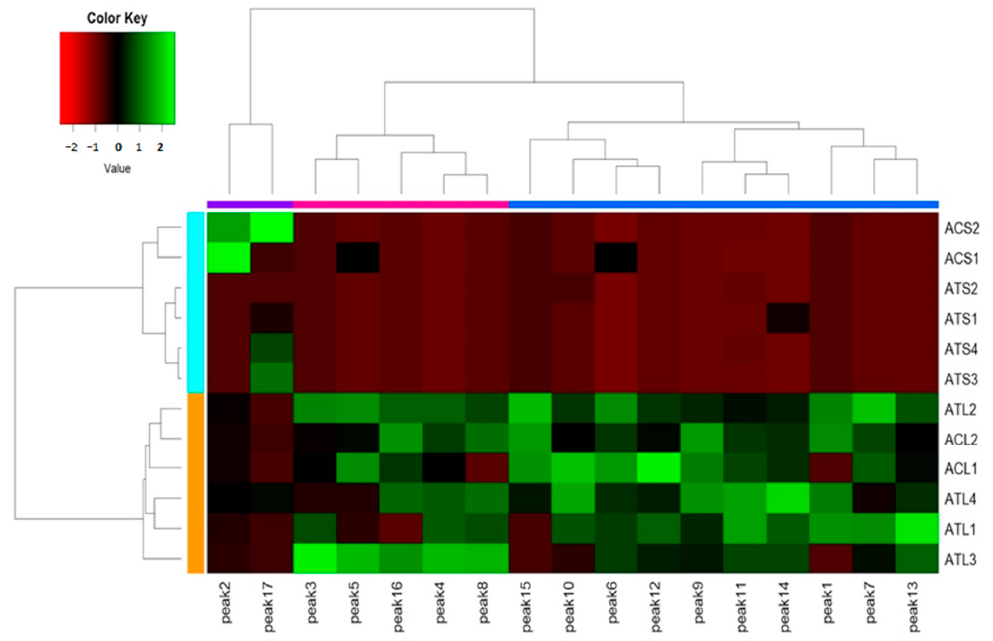
Figure 3. Heat map of contents of phenolic compounds in Amaranthus